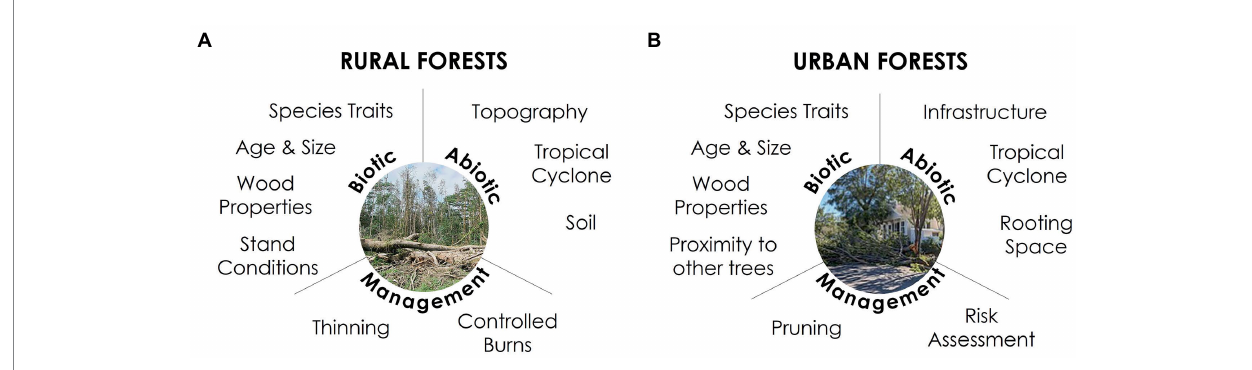
FIGURE 2 Conceptual diagram of factors that affect tropical cyclone damage to trees in rural (A) and urban (B) settings. Photo credit: Bob Linsdell, CC BY 3.0, and Bart Everson, CC BY 2.0, via